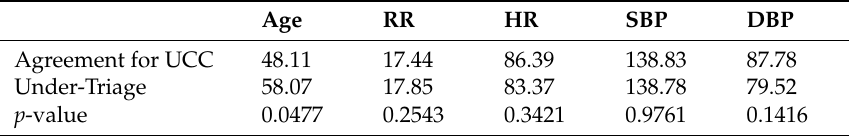
Table 6. Mean (x) differences in age and ED triage vital